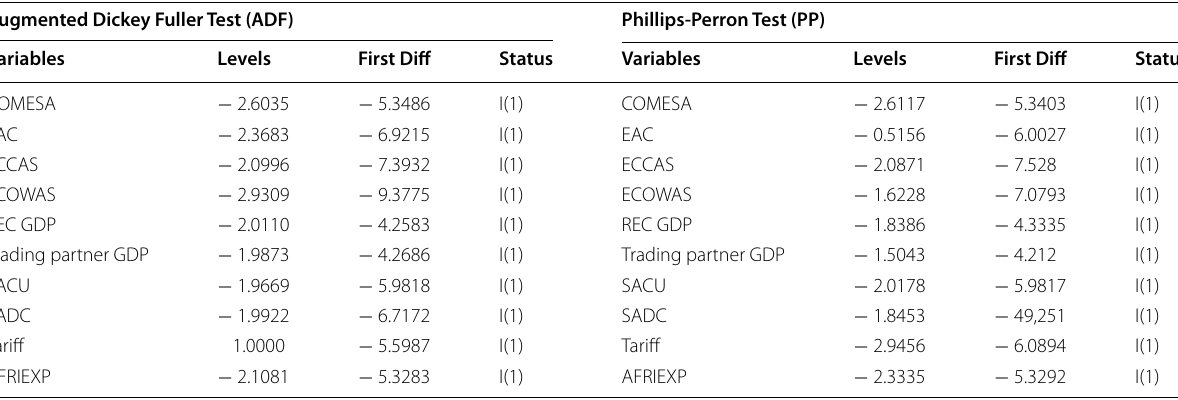
Critical values for ADF are Critical values for PP are